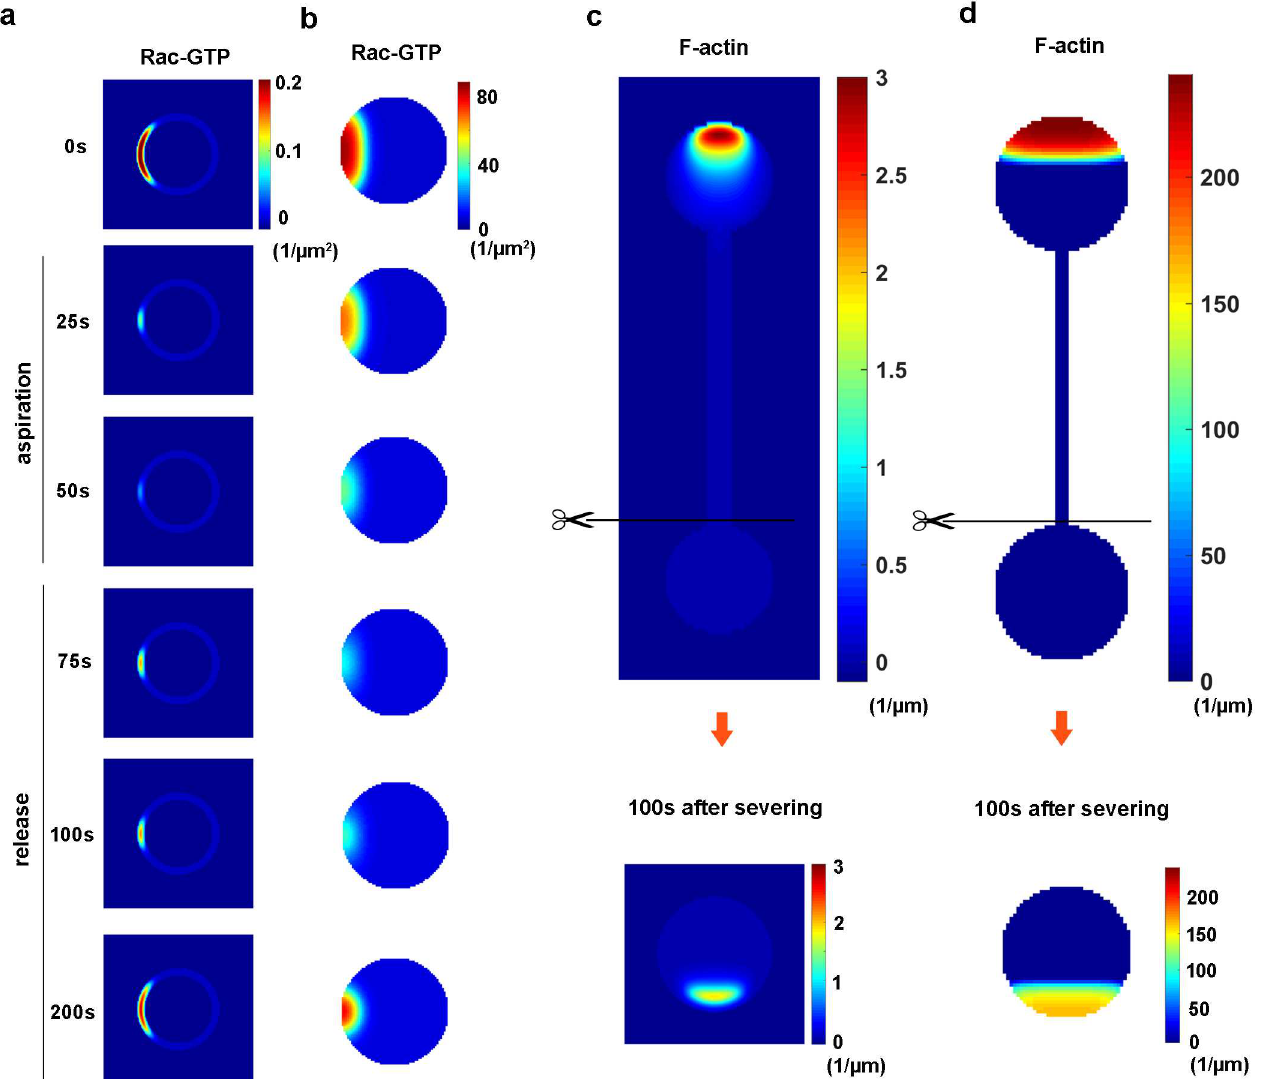
Fig 4. Simulations of the aspiration-release experiment and the severing experiment using the cell polarity model with phase field formulation (a and c) and the traditional cell polarity model coupled with membrane tension (b and d). (a-b) Rac-GTP dynamics in the polarizedcell decrease duringaspiration (elevatedmembranetension) due to the inhibitionof Rac-GTP. After release (a suddendecrease of membranetension), the cell recovers its active Rac-GTP levels and regains its polarity. (c-d) A polarized cell forms a steady morphologywith a pseudopod, neck and body. F-actin only concentrates at the front of the pseudopod.When the pseudopod and the neck are severed, the cell exhibits new polarity in the nonpolarizedrear cell